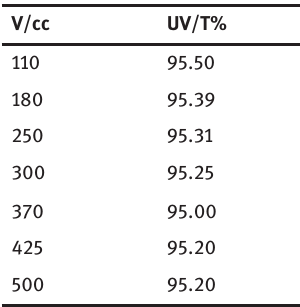
Table 4: The volume of samples 8BV.hr -1 compared the UV output from the